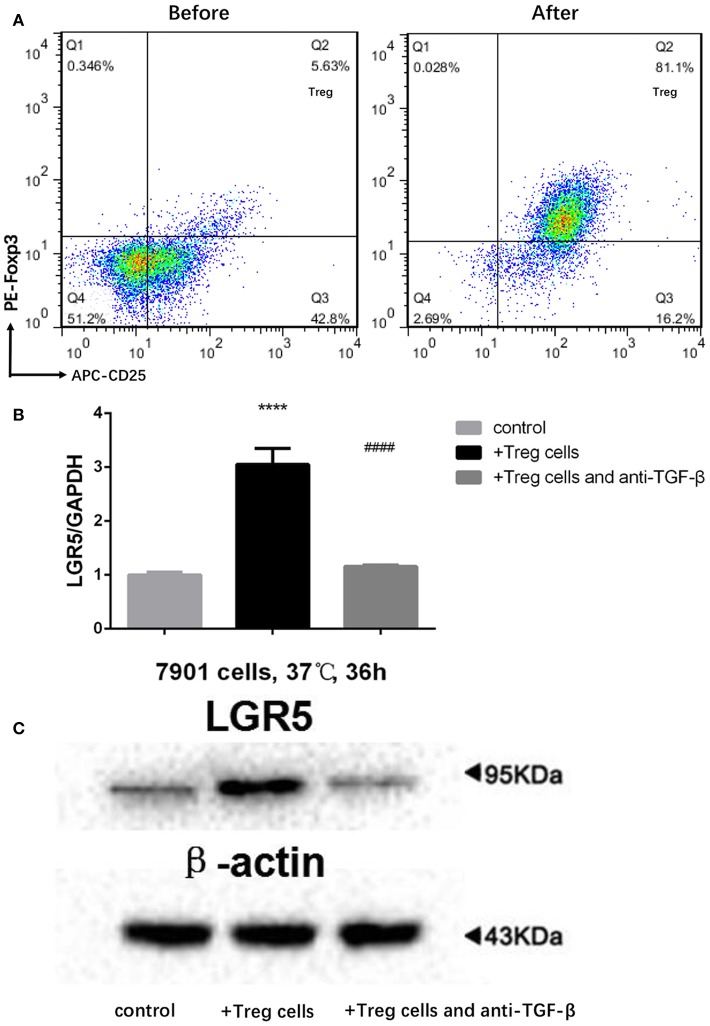
Treg-derived TGF-β1 as the main factor inducing high Lgr5 expression in GC cells. (A) Flow cytometric CD4-gated analysis of CD25+FoxP3+ cells was carried out in GC patient samples before and after MACS. (B,C) Tregs induce high Lgr5 expression in GC cells. GC cells were treated with Tregs (1 × 104 cells/mL) with and without TGF-β1 neutralizing antibody (1 μg/ml) for 36 h. Lgr5 expression was detected by western blot and qRT-PCR. mRNA expression was normalized to GAPDH. ****P < 0.0001 between Treg-treated SGC-7901 cells and control group. ####P < 0.0001 between Treg-treated SGC-7901 cells with or without TGF-β1 neutralizing antibody (1 μg/mL). GAPDH, glyceraldehyde 3-phosphate dehydrogenase; GC, gastric cancer; Lrg5, leucine-rich repeat containing G protein-coupled receptor 5; MACS, magnetic-activated cell sorting; qRT-PCR, quantitative revere transcription polymerase chain reaction; TGF-β1, transforming growth factor beta 1.